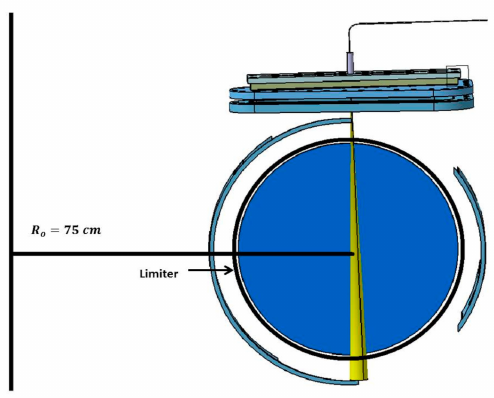
Figure 2. Scheme of wavelength calibration for poloidal rotation measurement on Aditya-U tokamak.